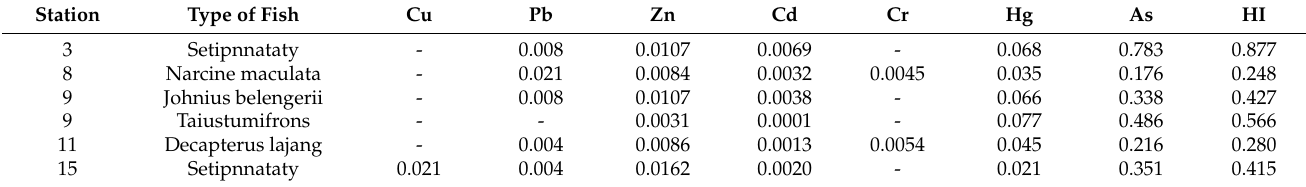
Table 10. Target hazard quotient (THQ) and Hazard index (HI) of heavy metals in fishes ( n = 6) obtained from Haikou Bay and adjacent waters.